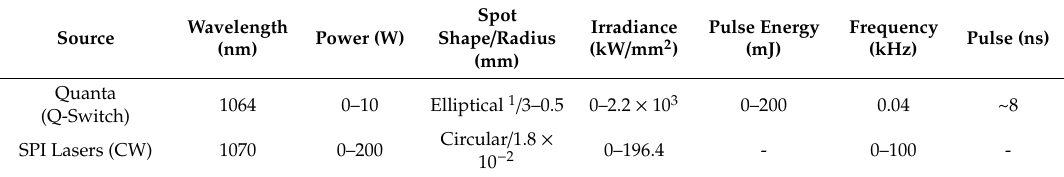
Table 2. Laser source characteristics.